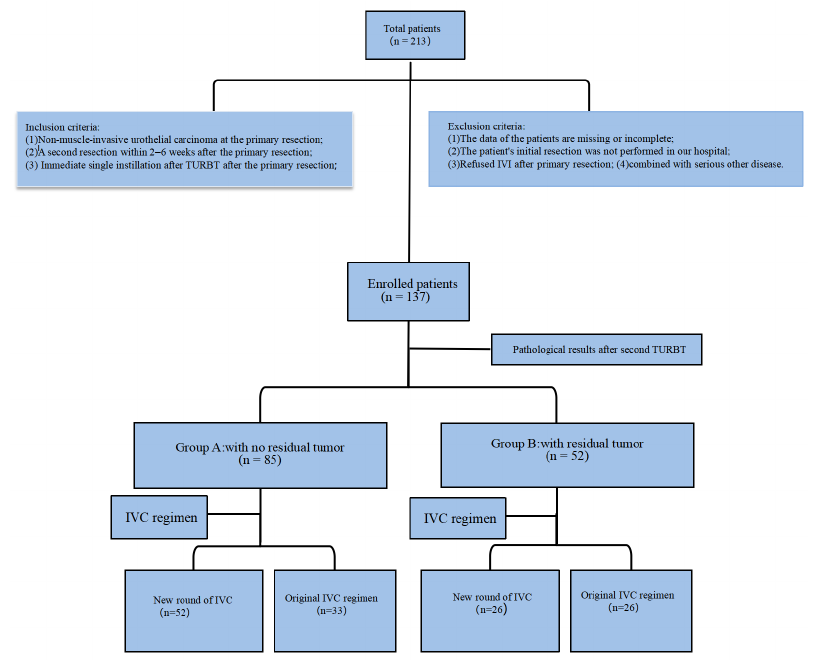
Figure 1. Flow chart of allocation. Table 1. Patient characteristics.